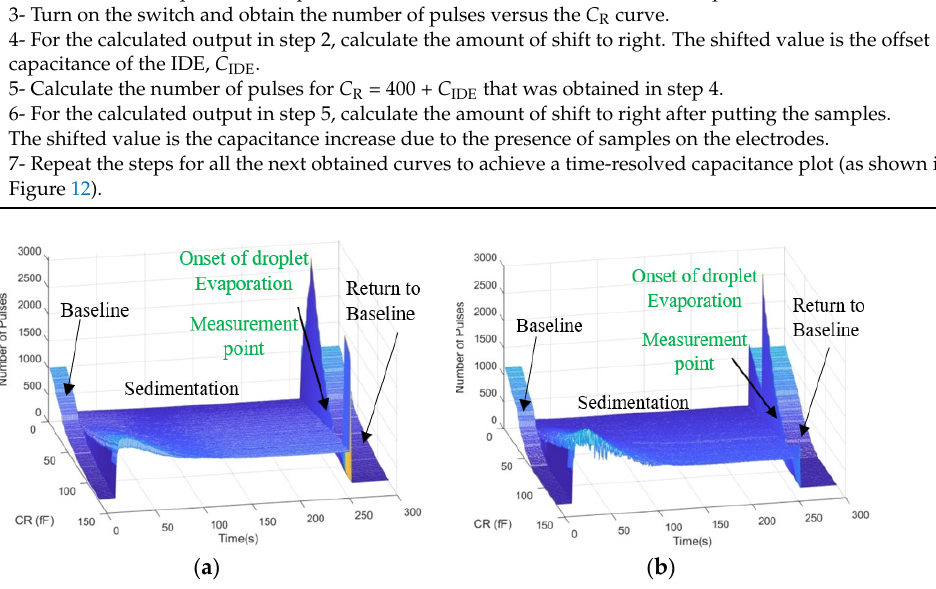
Figure 14. The 3D output of the chip for the first run of the oral samples experiments for ( a ) Left IDE, ( b ) Right IDE. Algorithm 1. Capacitance extraction algorithm from the 3D